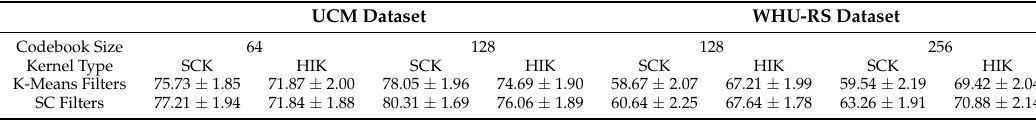
Figure 13. Results on two datasets with the histogram intersection kernel (HIK) and joint kernels with different filter settings. ( a ) Results on the UCM dataset with SC filters (9 9 pixels); ( b ) results on the × WHU-RS dataset with SC filters (9 9 pixels); ( c ) results on the UCM dataset with K-means filters × (7 7 pixels); ( d ) results on the WHU-RS dataset with K-means filters (7 7 pixels). × × Table 3. Performance comparison between SCK and